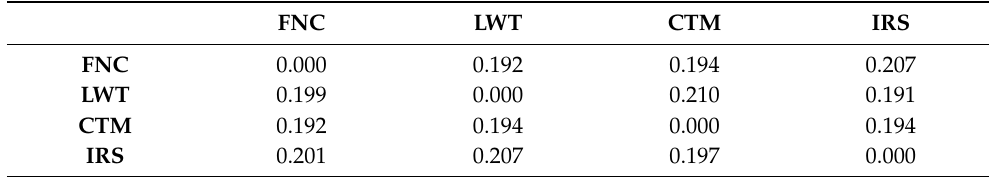
Table A9. Score function values of the perspectives.